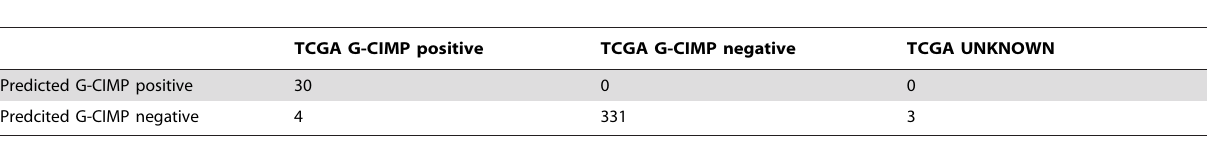
Table 1. Comparison of TCGA G-CIMP labels and our G-CIMP